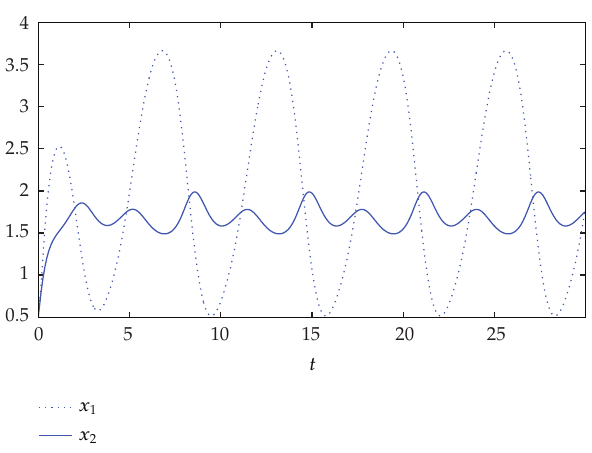
Figure 1: Time response of state x 1 ,x 2 of system (cid:6) 4.1 (cid:7) with initial value (cid:6) 0 . 1 , 0 . 1 (cid:7) and K 1 (cid:8)